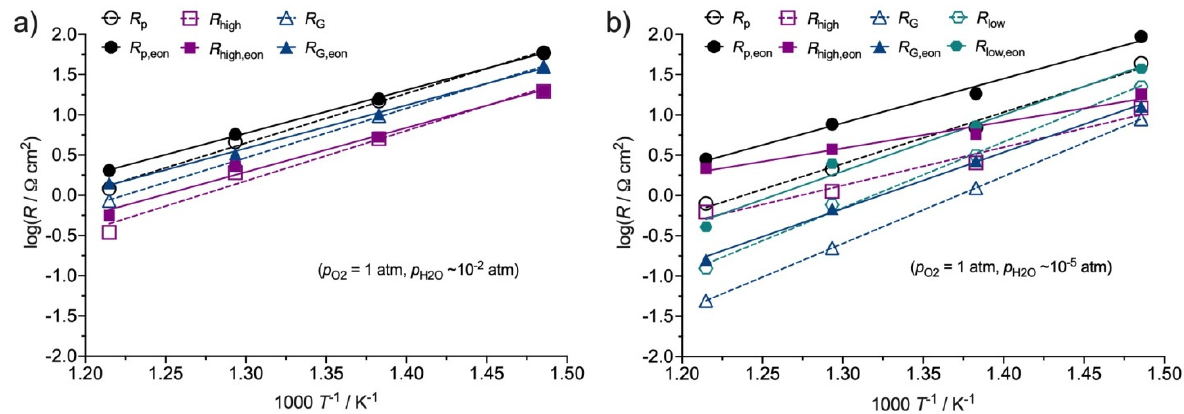
Figure 9. Temperature dependence of the polarisation resistances with and without the electronic pathway correction for: ( a ) Wet ( p H2O ~ 10 − 2 atm) and ( b ) low humidity ( p H2O ~ 10 − 5 atm) conditions at 450 °C in O 2 atmosphere.